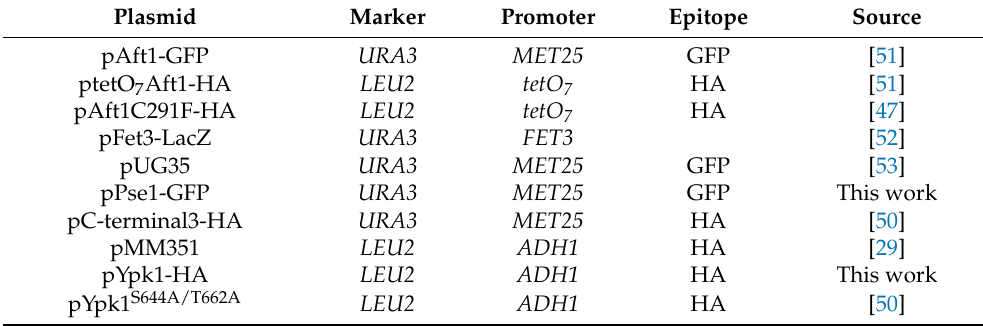
Table 2. Plasmids